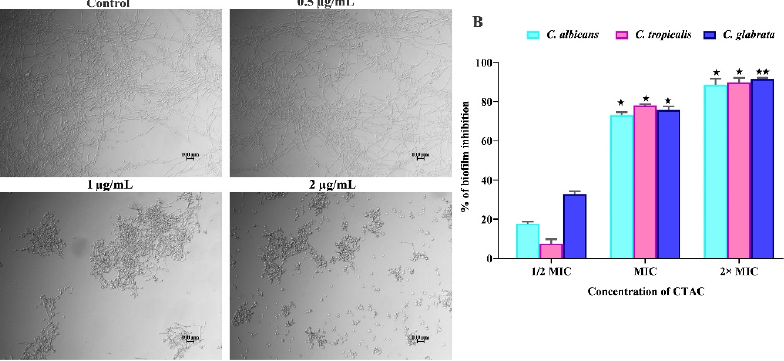
Figure 7. The influence of CTAC on virulence traits of Candida species. ( A ) Effect of CTAC (at sub ‐ MIC) on yeast ‐ to ‐ hyphae transition in C. albicans . After 24 h incubation, samples were visualized under a light microscope (magnification—200×; scale bar—50 μ m). ( B ) The evaluation of CTAC efficacy against mature biofilm production by Candida species through crystal violet staining. * and ** represent statistical significance at p < 0.05 and p < 0.01, respectively. In addition to biofilm formation, the yeast ‐ to ‐ hyphal transition of C. albicans and C.